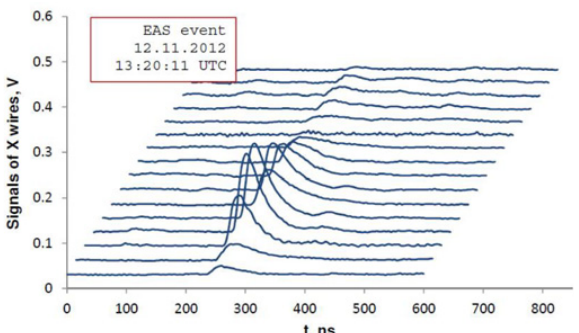
Figure 9. The Cherenkov pulse shape detected using 32 channels of the telescope DAS: 16 X wires.